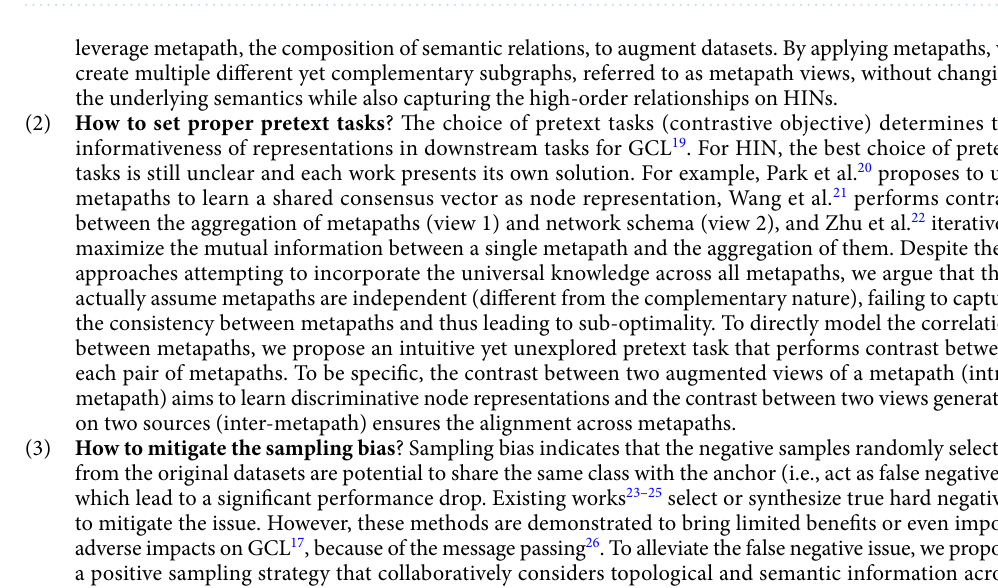
Figure 1. An example of heterogeneous information